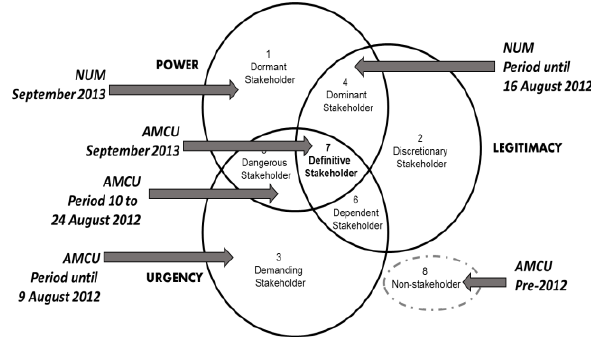
Figure 9: Stakeholder typology applied to NUM and AMCU (adapted from Mitchell et al ., 1997: 874) NUM was the recognised, legitimate union due to attaining the legislatively required 50% membership, and had